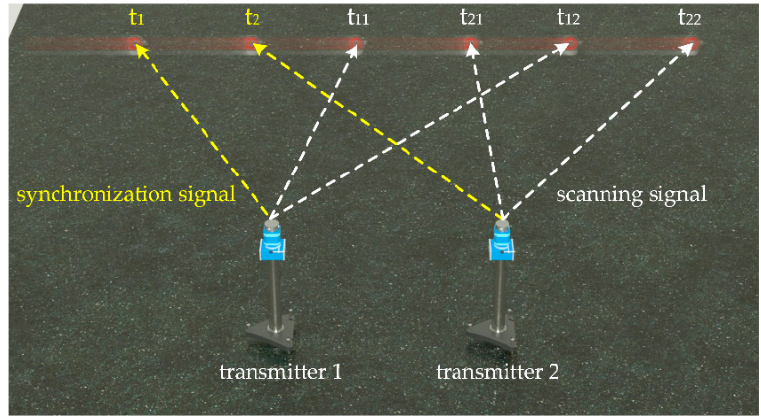
Figure 2. Time sequence of signals from two transmitters.